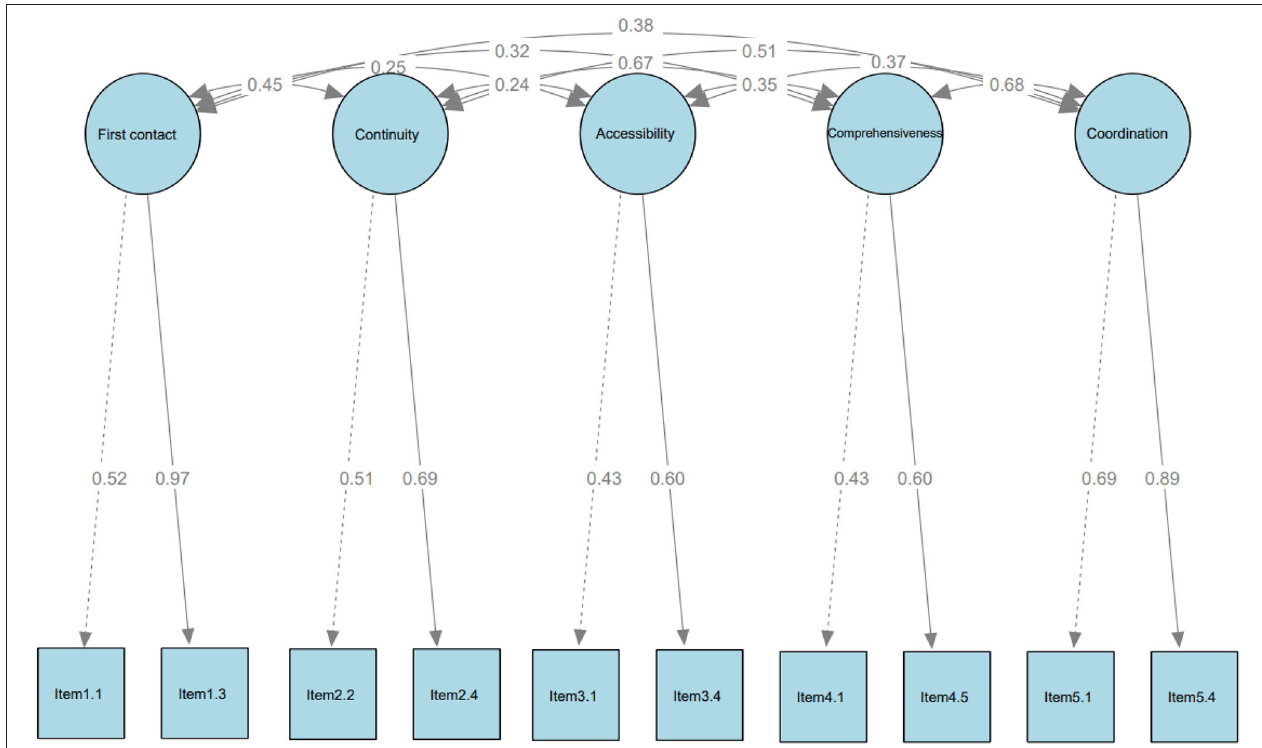
FIGURE 2 | Confirmatory factor analysis of the RA-ASPC using Dampened weighted least squares (DWLS) as estimator ( N = 604). Chi-square minimum = 24.081; Degree of freedom = 25; Goodness of Fit Index (GFI) = 0.996; Comparative Fit Index (CFI) = 1.000; Root Mean square Residual (RMR) = 0.022; Root Mean Square Error of Approximation (RMSEA) = 0.000. Details of the items could be found in Appendix 2